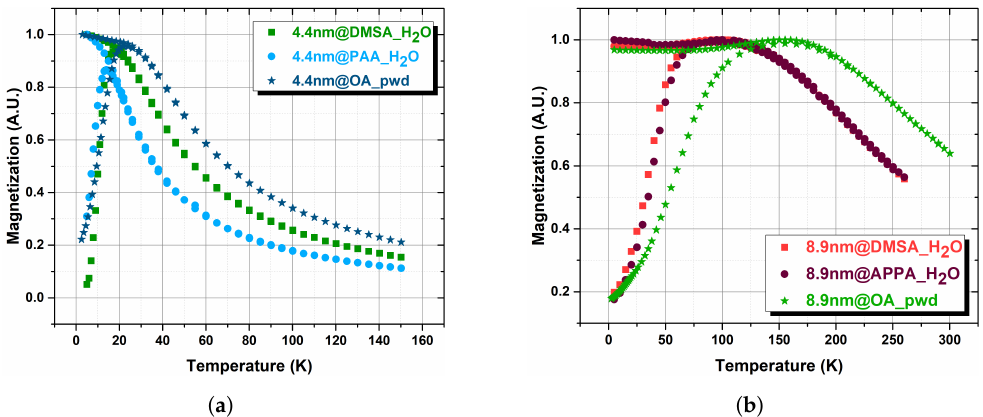
Figure 4. Zero Field Cooled-Field Cooled magnetization of the 4.4 nm ( a ) and 8.9 nm ( b ) set of MNPs collected in a magnetic field µ 0 H = 5 mTesla; _pwd stands for powders and _H 2 O for samples in water dispersion. Table 1. Blocking temperature T B of the first and second set of